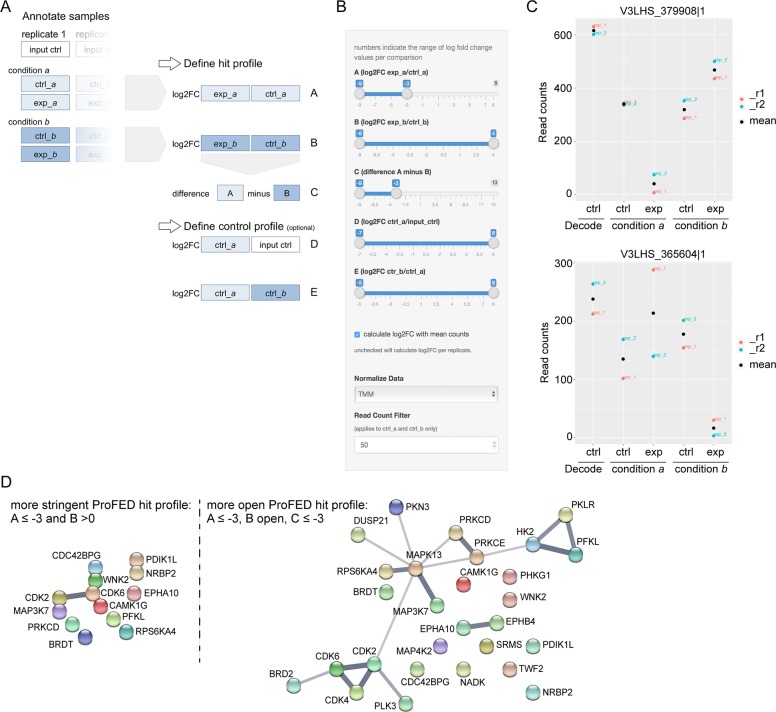
Profile filtering approach for the identification of screen hits.(A) Illustration of sample annotation and basic profile filter parameters. Shading indicates that additional replicates are optional. FC = fold change. (B) Screen-shot from the ProFED online tool showing the “slider” panel used to set fold change thresholds and limits of desired hit profiles. The depicted setting filters for targets specific to condition a. (C) Exemplary read count profiles of hits specific to condition a (A673; top panel) and b (HEK293; bottom panel) as generated by ProFED. (D) STRING analysis of reported and predicted protein-protein interactions among condition a (A673)-specific hits. 13 hits filtered with a stringent ProFED profile (Table 1A) were analyzed in comparison to 28 hits based on a more open hit profile (Table 1A plus 1B). Line thickness indicates the strength of data support.